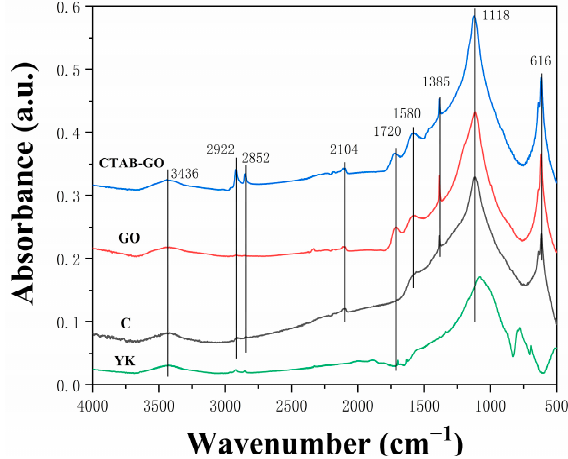
Figure 2. FT-IR of graphite powder, graphene oxide, CTAB-modified graphene oxide, and coconut shell coke.